Question: What style of plot is this figure drawn as?
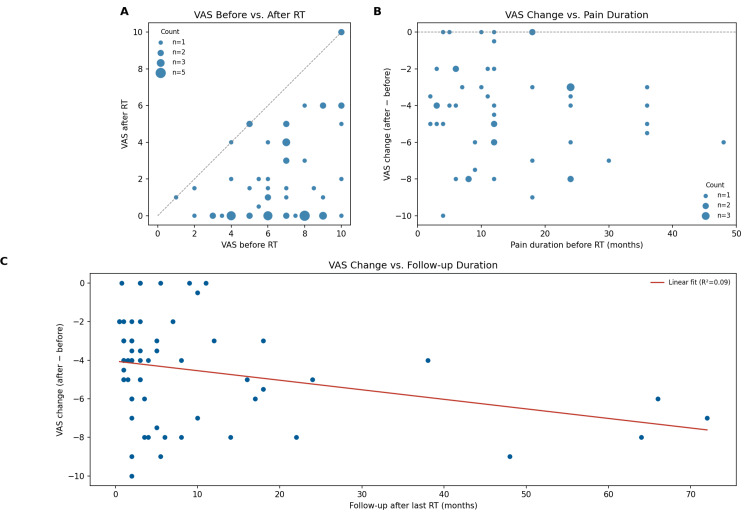
Answer: scatter